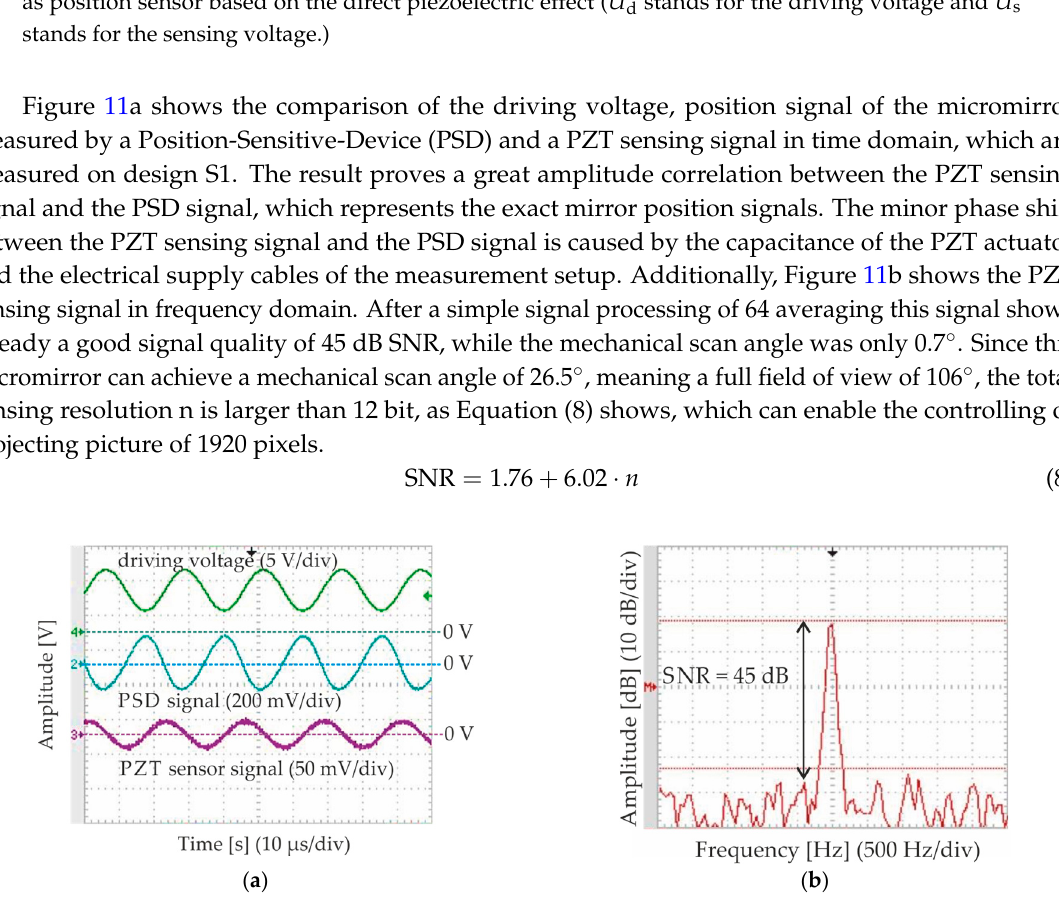
Figure 11. Measurement results of the PZT sensing signal of design S1: ( a ) Comparison of driving voltage (green), PSD position signal (blue) and PZT position signal (violet) in time domain; ( b ) PZT position signal in frequency domain with a SNR of 45 dB after 64 averaging process at a mechanical scan angle of 0.7°. PSD = Position-Sensitive-Device; SNR = signal-to-noise-ratio.